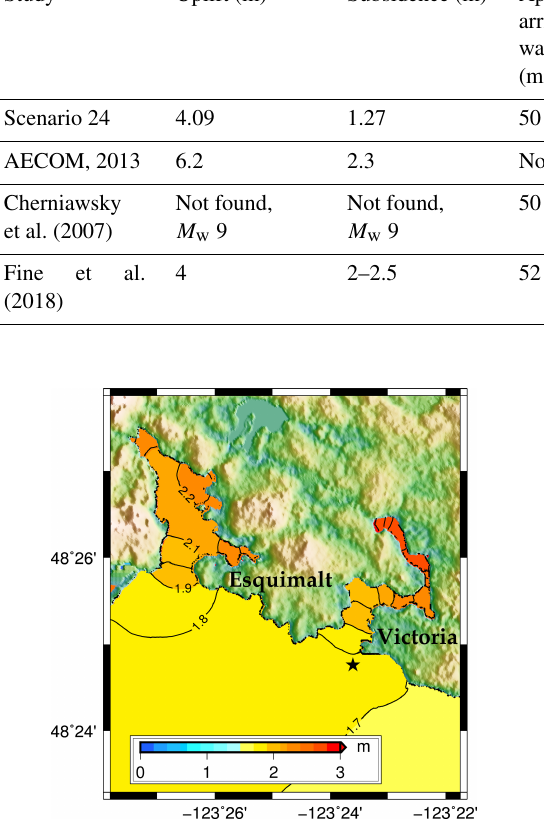
Figure 8. The contours of the maximum elevation from scenario 24. The black star denotes the design location used to drive the experi-